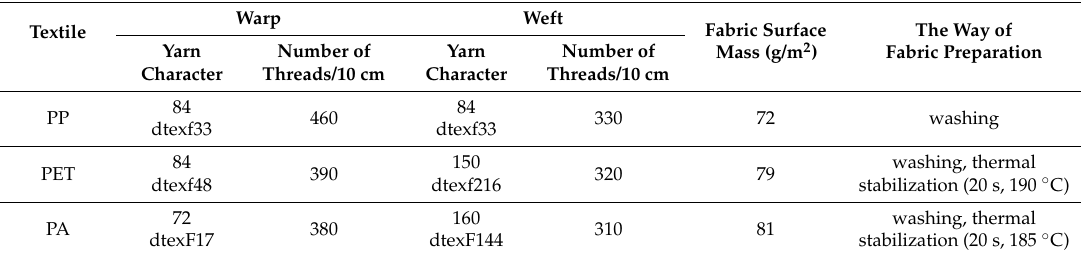
Table 1. Characteristic features of used textile superficially